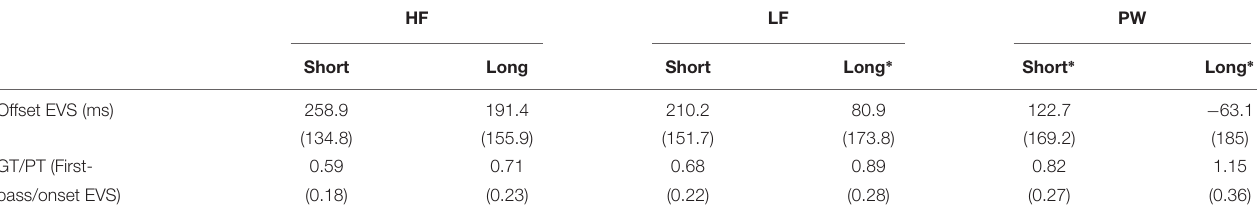
TABLE 1 | Means (standard deviation) for offset EVS and GT/PT.